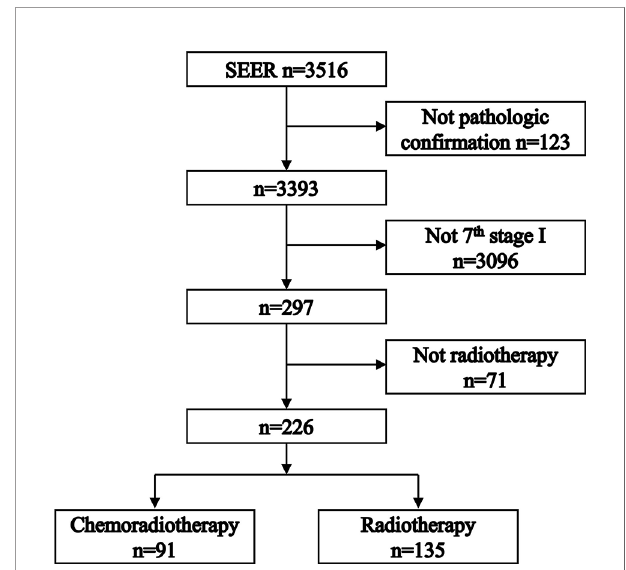
FIGURE 1 | Flowchart depicting patient